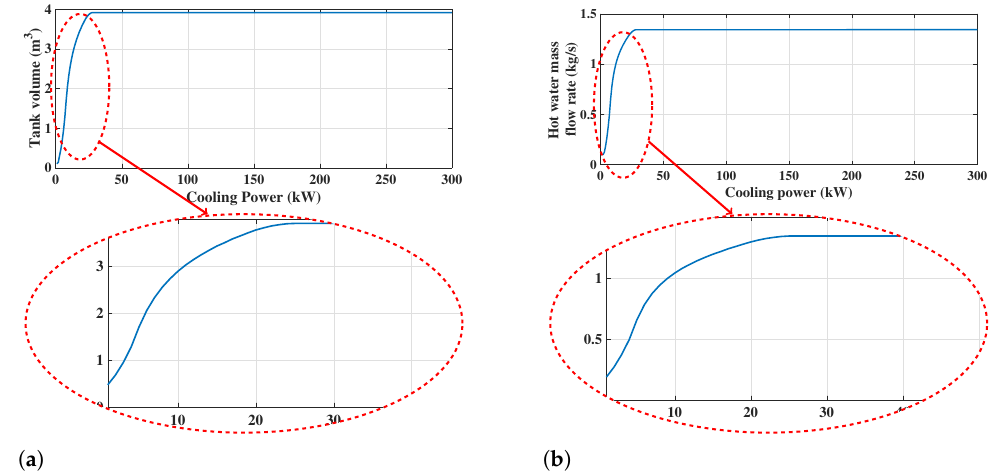
Figure 6. ( a ) Storage tank volume versus different cooling power, ( b ) hot water mass flow rate versus different cooling